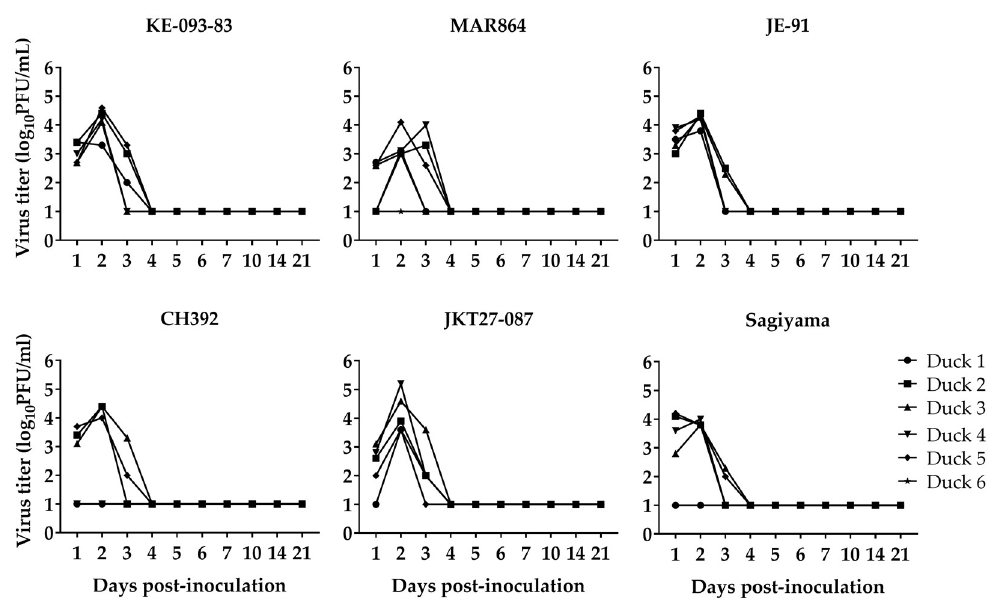
Figure 4. Viremia in ducklings inoculated with Japanese encephalitis viruses. Ducking 6 for both MAR864 and Sagiyama groups were non-inoculated controls. Virus titers < 2 were below the limit of detection.